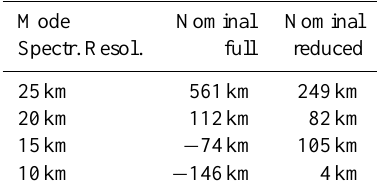
Table 5. Information displacement for CFC-11 retrievals. Negative distances are displacements away from the satellite, beyond the tan- gent point. Positive distances are displacements towards the satel- lite.